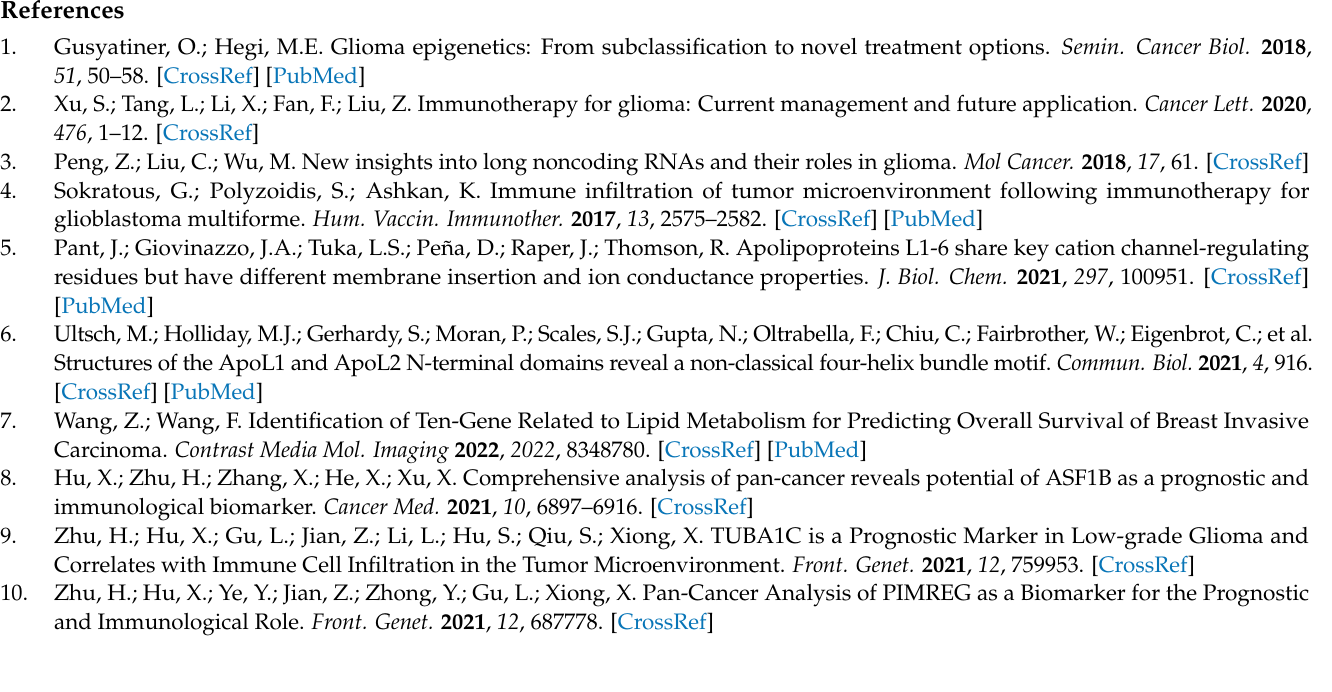
Table S1: Full names and abbreviations of 33 types of